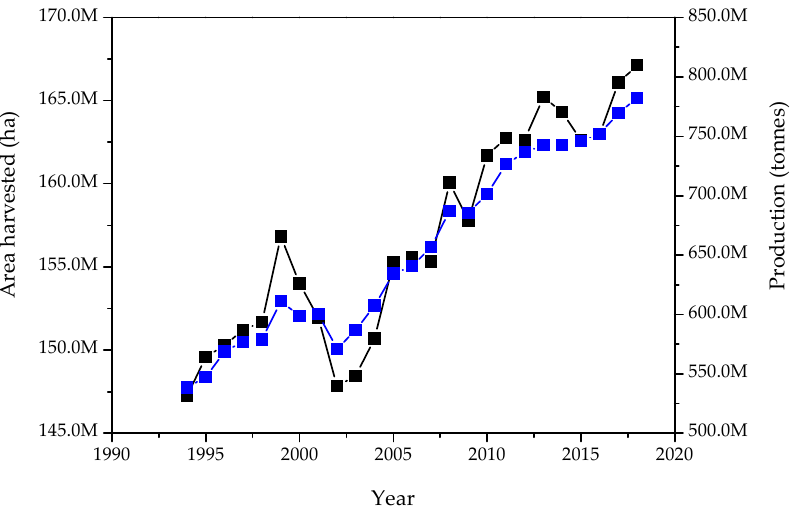
Figure 2. World production of paddy rice according to FAOSTAT. Black line: area harvested and blue line: production yields.